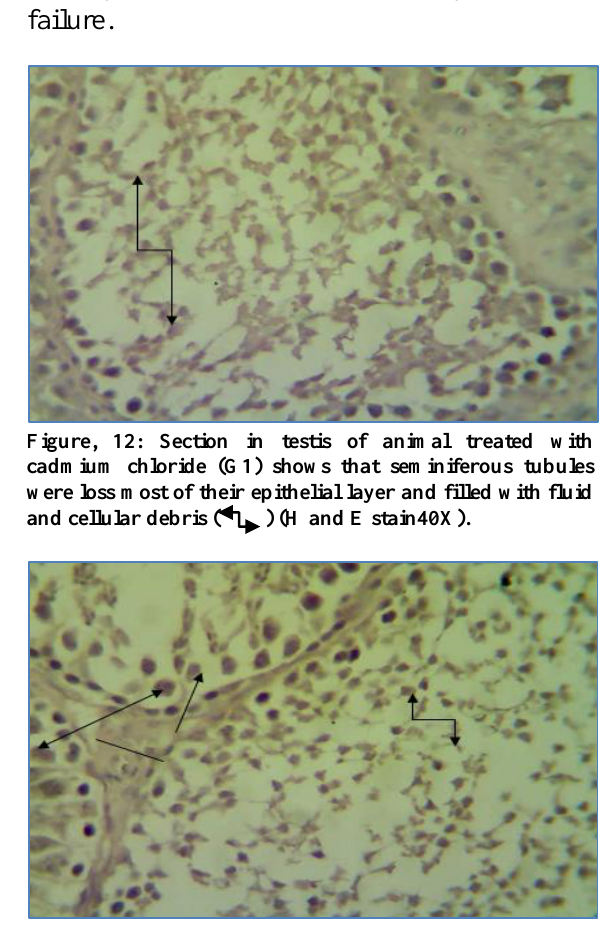
Figure, 13: Section in testis of animal treated with cadmium chloride (G1) shows that seminiferous expressed thickness of basement membrane ( ) line only by Sertoli cells ( ) with congested blood vessels and few Leydig cells ( ) and filled with cellular debris ( ), (H and E